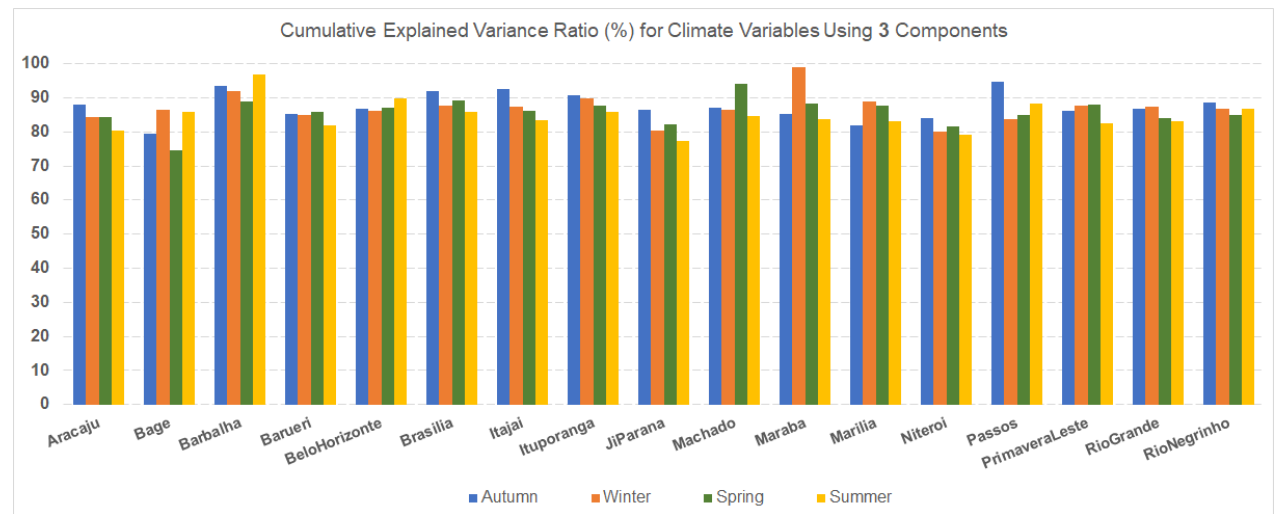
Figure 11. Overview of the percentage of representation of the variance of climate variables consid- ering three principal components. Source: own authors. ing three principal components. Source: own